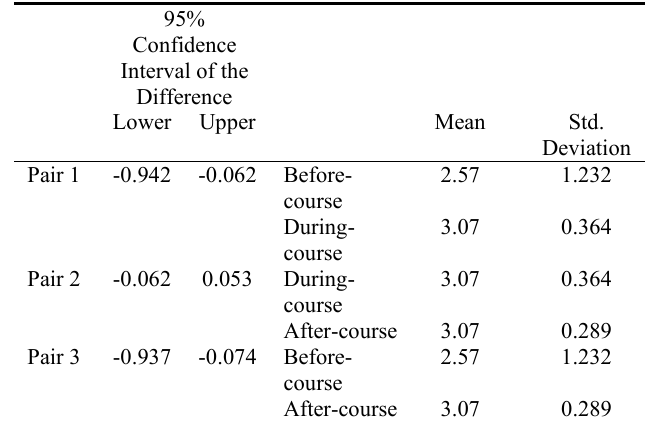
Table 1. Descriptive statistics of the three pairs in the